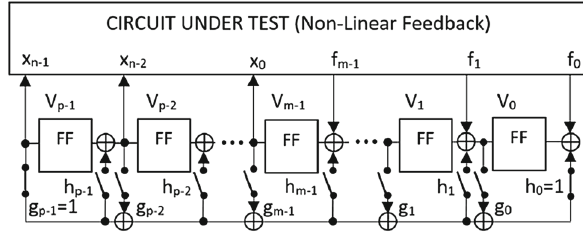
Fig. 5 External–internal, top–bottom ExOR register